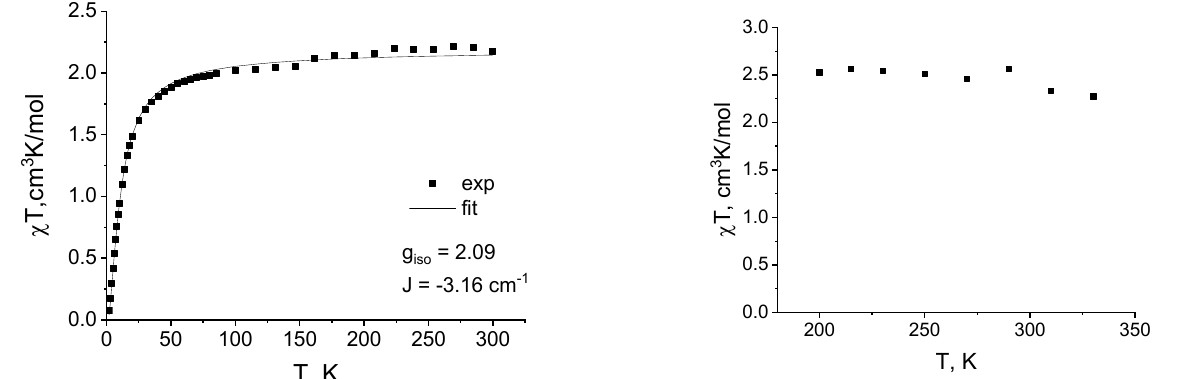
Figure 2. Variable-temperature magnetic susceptibility for a microcrystalline sample ( left ) and a methanol solution ( right ) of [(bipy) 4 Ni 2 (L)]Cl from the dc-magnetometry and the Evans technique, respectively. For the magnetic susceptibility of a methanol solution of [(phen) 4 Ni 2 (L)]Cl , see Figure S7.